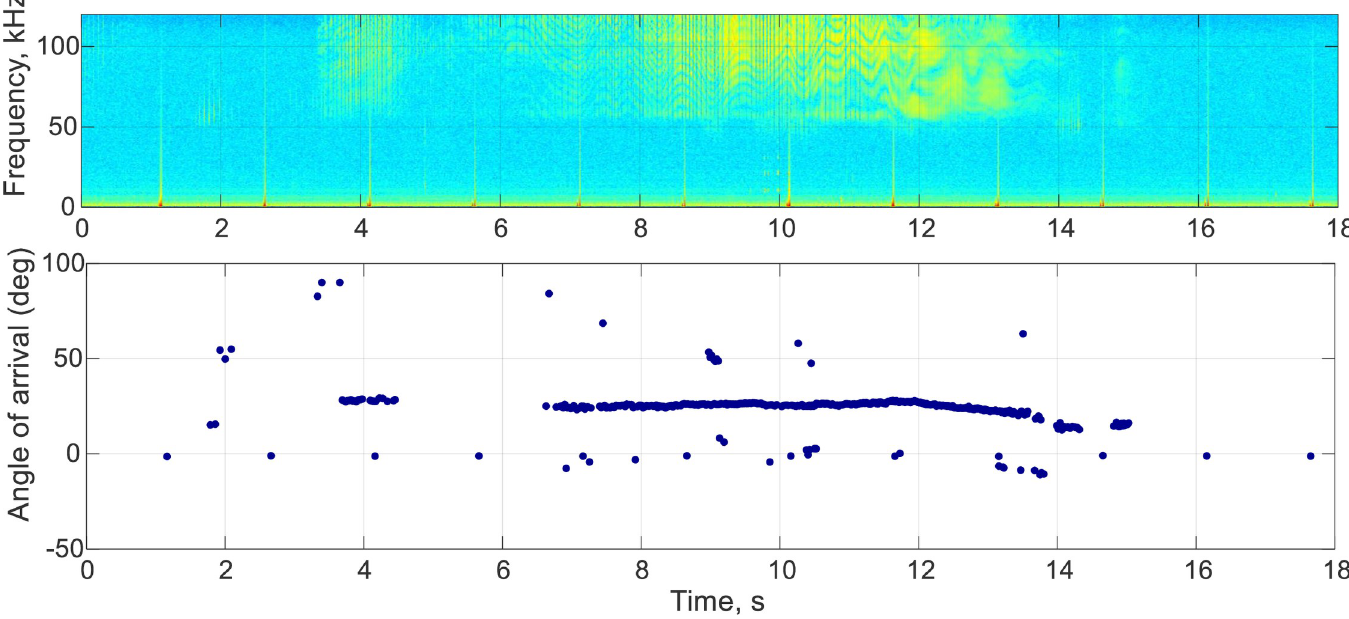
Fig 2. Spectrogram (upper panel) showing 18 s of data from DLBB16-04 emitting a feeding click train ending in a terminal buzz, corresponding angle of arrival of each click (horizontal blue line in the 20–25 degrees) measured with script d3findclicks from the DTAG toolbox. Time zero equates to 1.9 hrs since the whale was released, or 21:26 AKDT on 14 May 2016.